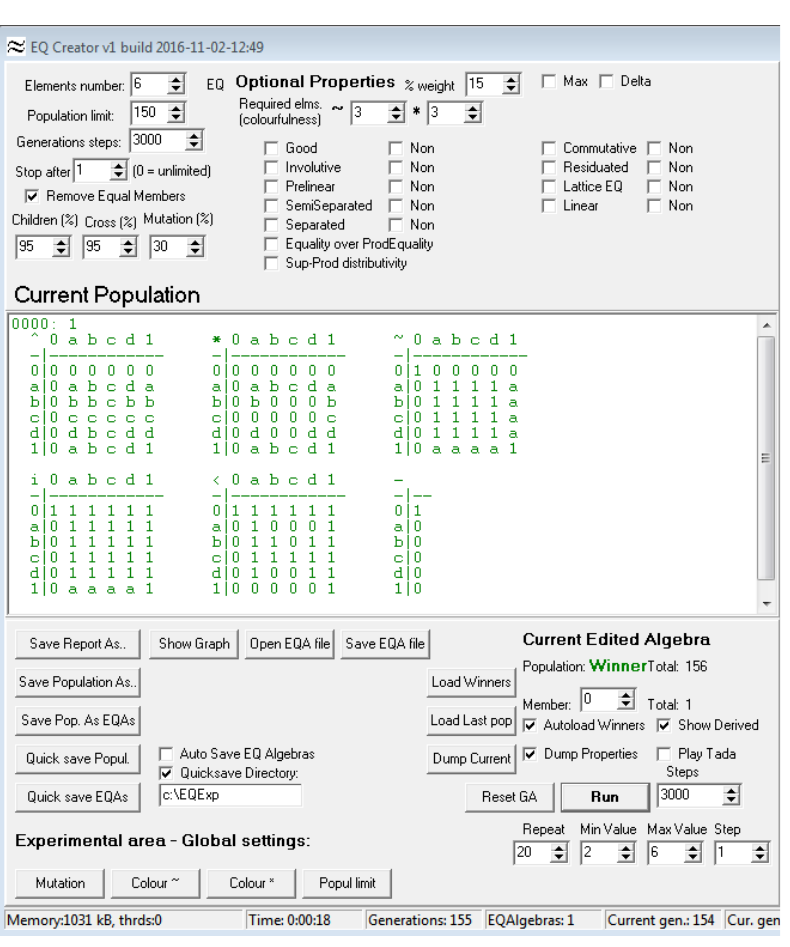
Figure 3. EQCreator showing the generated